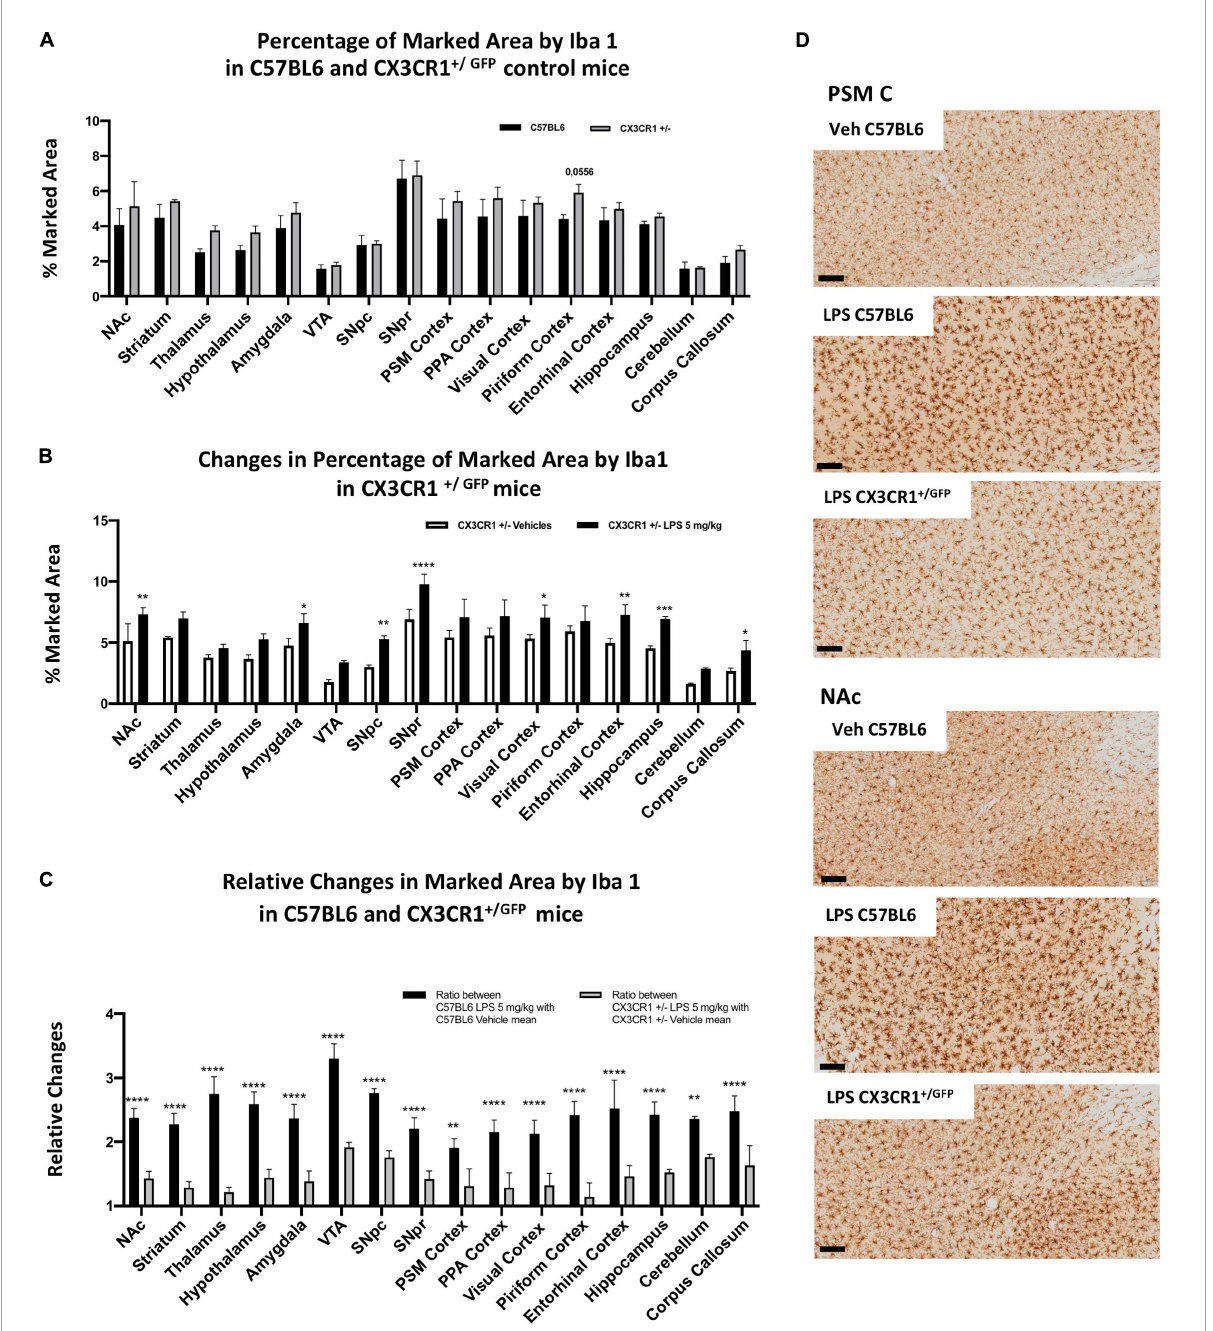
FIGURE6 Microglia heterogeneity in CX3CR1 + / GFP mice. (A) Percentage of the marked area by Iba1 between C57BL6 (black column) and CX3CR1 + / GFP mice (gray columns) in control conditions. Two-way ANOVA. F BrainRegions (15, 64) = 32.50, p < 0.0001. F Genotype (1, 64) = 36.68, p < 0.0001. F Interaction (15, 64) = 0.7510, p < 0.7241, and n = 3 mice per region. Significance: (*) respect same regions between two genotypes. (B) Percentage of the marked area by Iba1 positive cells in CX3CR1 + / GFP mice. Vehicles (white columns) and LPS treated mice (black columns). Two-way ANOVA. F BrainRegions (15, 64) = 34.78, p < 0.0001. F Treatment (1, 64) = 164.9, p < 0.0001. F Interaction (15, 64) = 1.327, p < 0.2129, and n = 3 mice per region. Significance: (*) respect relative vehicles. (C) Relative changes in percentage of the marked area by Iba1 between LPS 5 mg/kg and vehicles mice 24 h after treatment in C57BL6 mice (black columns) and CX3CR1 + / GFP mice (gray columns). Two-way ANOVA F BrainRegions (15, 64) = 10.13, p < 0.0001. F Treatment (1, 64) = 687.5, p < 0.0001. F Interaction (15, 64) = 2.862, p < 0.0018, and n = 3 mice per region. Significance: (*) respect relative vehicles. (D) Representative images of Iba1 staining in PSM cortex and NAc in C57BL6 and CX3CR1 + / GFP mice treated with 5 mg/kg LPS or vehicles. Scale bar = 100